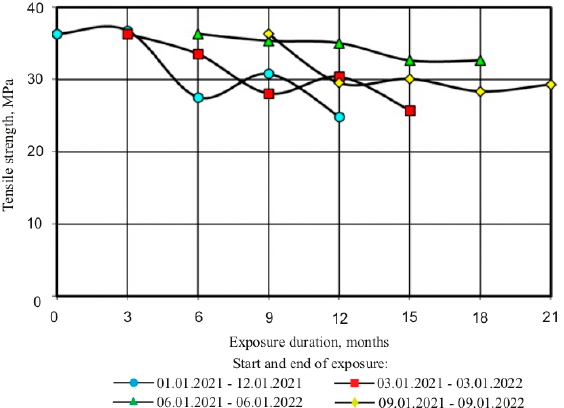
Figure 13. Change in the ultimate strength of specimens of the composition Etal ‐ 247 + Etal ‐ 45M in tension relative to the common time axis.